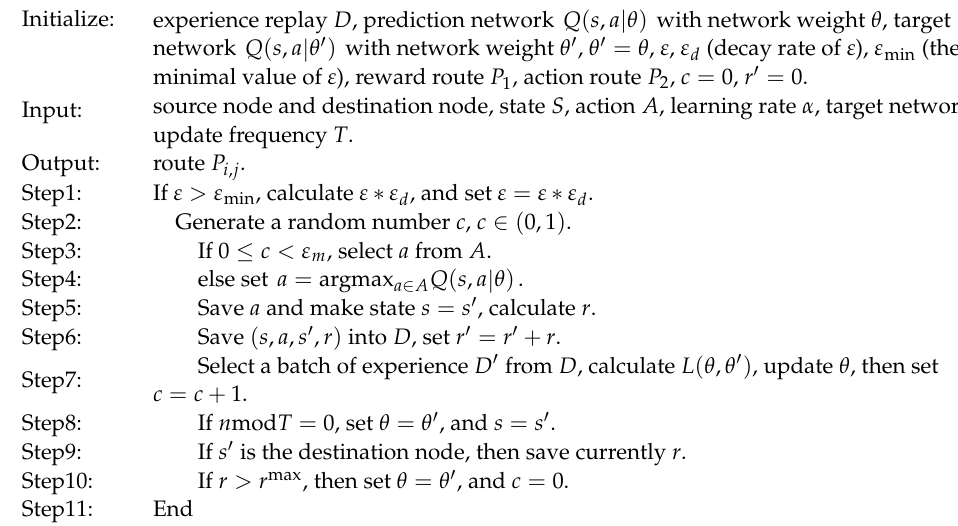
Algorithm 1. Intelligent message forwarding (DRL-IMF)